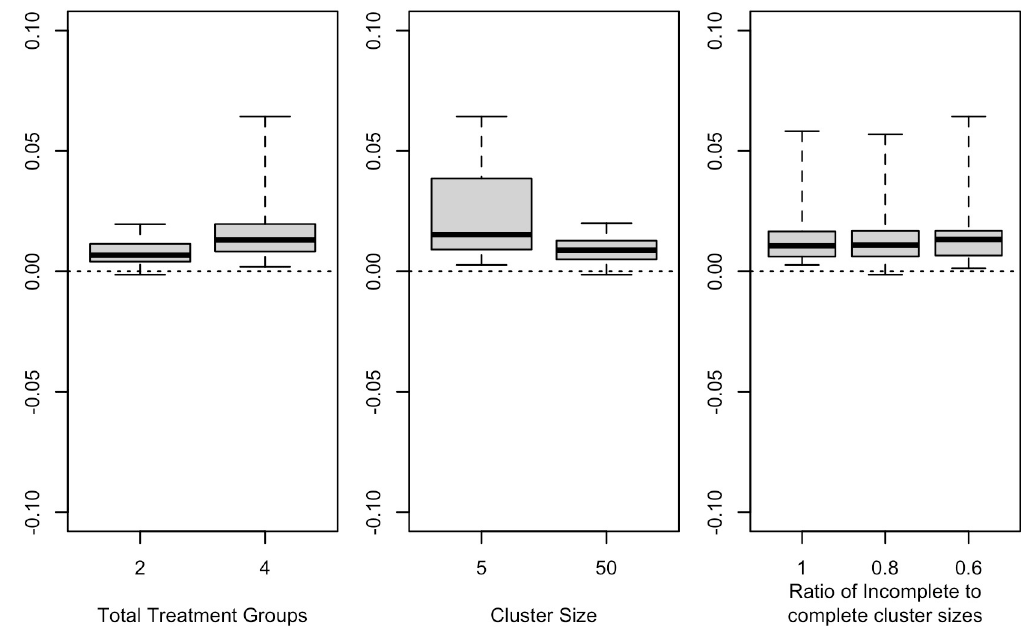
Fig 2. Power deviations for cluster randomized designs. (center line, median; box limits, 1st and 3rd quartiles; whiskers, minimum and maximum).